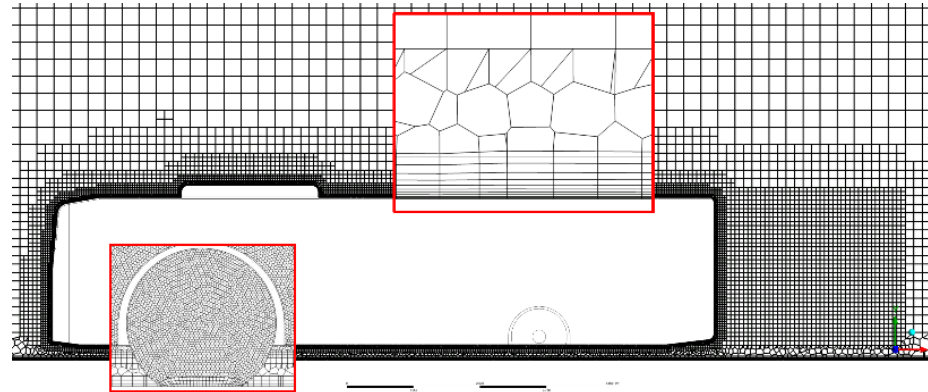
Figure 3. Vertical cross-section view of mesh2.